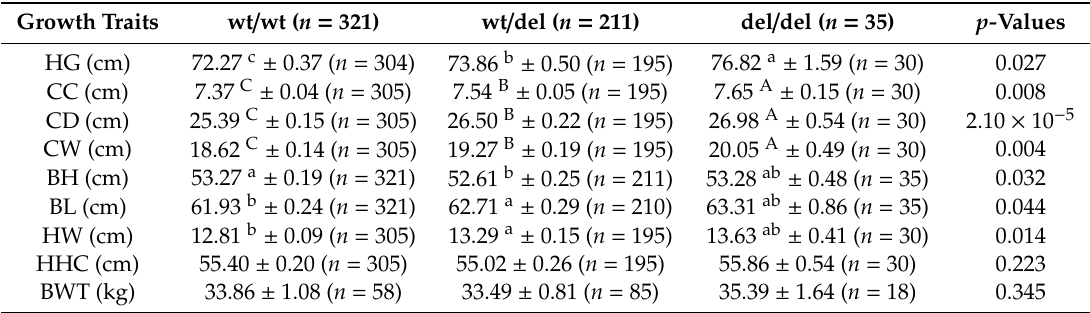
Table 4. E ff ects of PRDM6 gene deletion mutations and growth traits of Shaanbei white cashmere goats in the yearling period (mean ± standard errors).